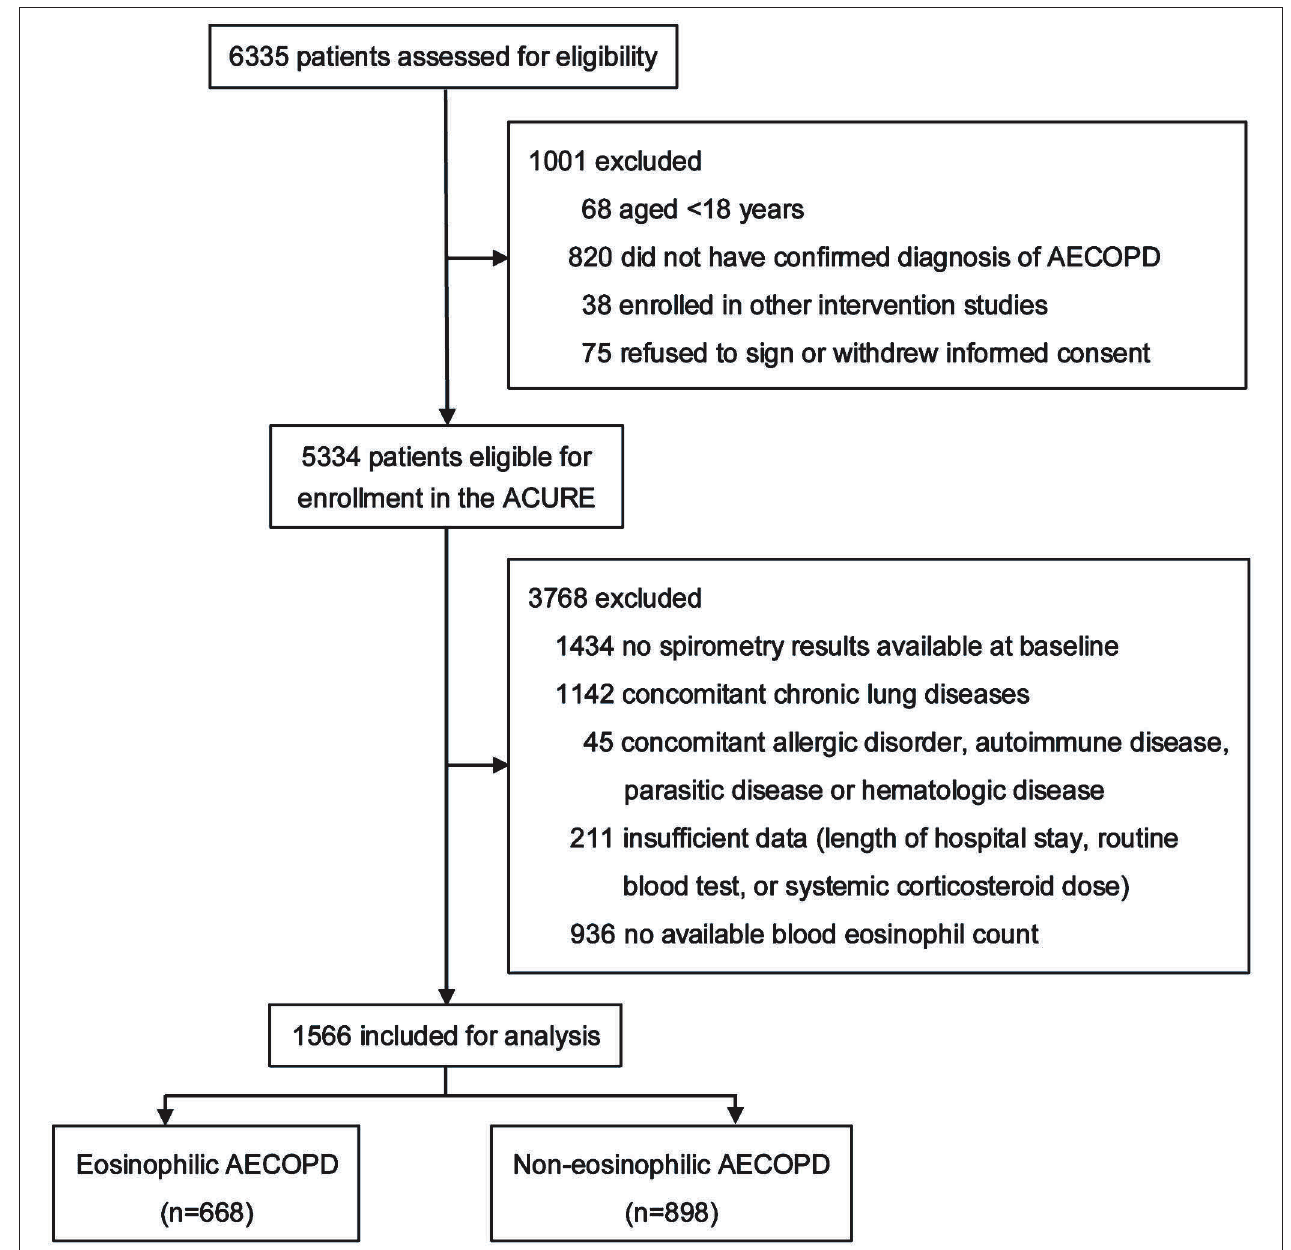
FIGURE 1 | Flowchart of patient enrollment process. AECOPD, acute exacerbations of chronic obstructive pulmonary disease; ACURE, acute exacerbation of chronic obstructive pulmonary disease inpatient registry study.